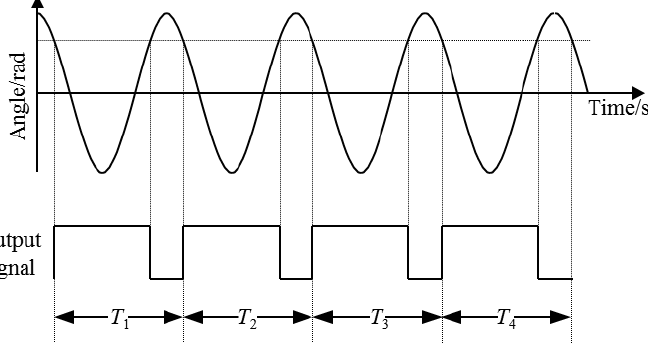
As shown in Figure 4, the period measurement adopts the switch timing method,